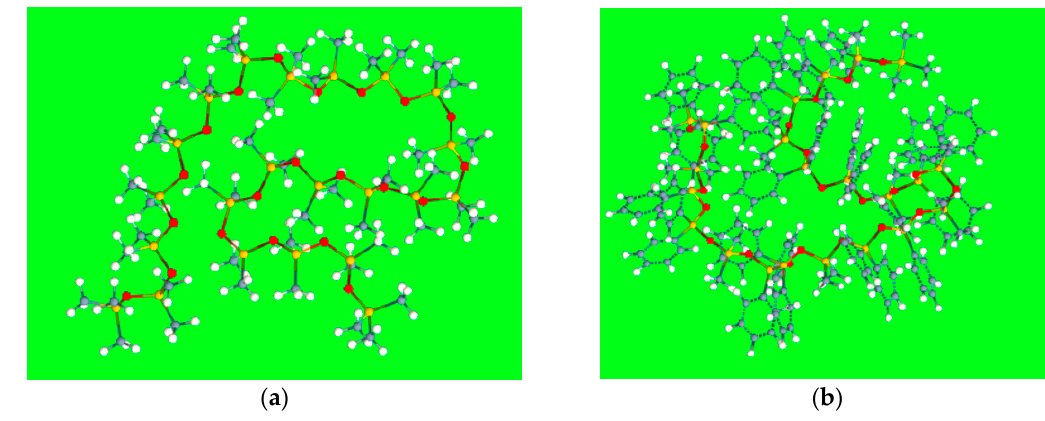
Figure 1. Geometrical models of OV-1 ( a ) and Rtx-65 ( b ) stationary phases. Grey, white, yellow and red colours identify C, H, Si and O atoms, respectively.